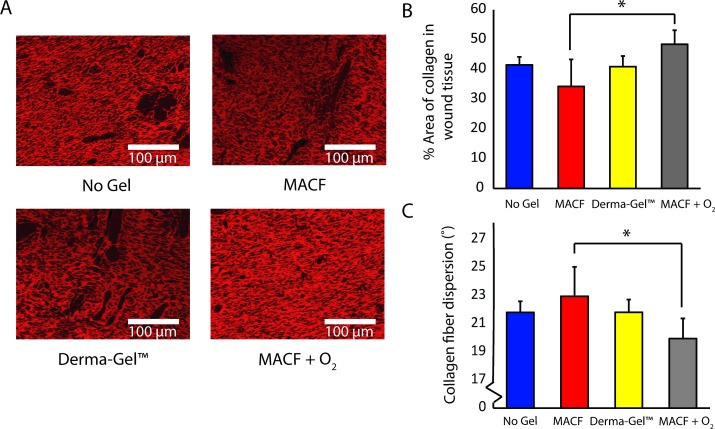
Picrosirius Red staining on wound tissue sections shows uniformly organized collagen deposition.A) Picrosirius red stained tissue images. B) % Area of collagen in tissue sample. C) Dispersion of collagen fiber orientation/directionality. Letters denote significance by ANOVA, (p < 0.05); n = 3 (wounds/treatment) for both collagen area and dispersion.